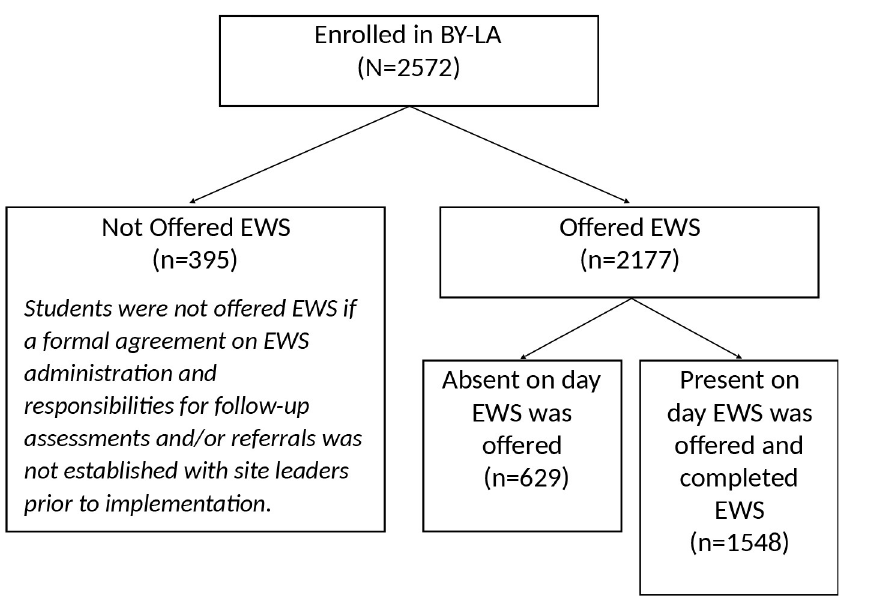
Fig 1. Consort diagram of BY-LA emotional wellness screener (EWS)